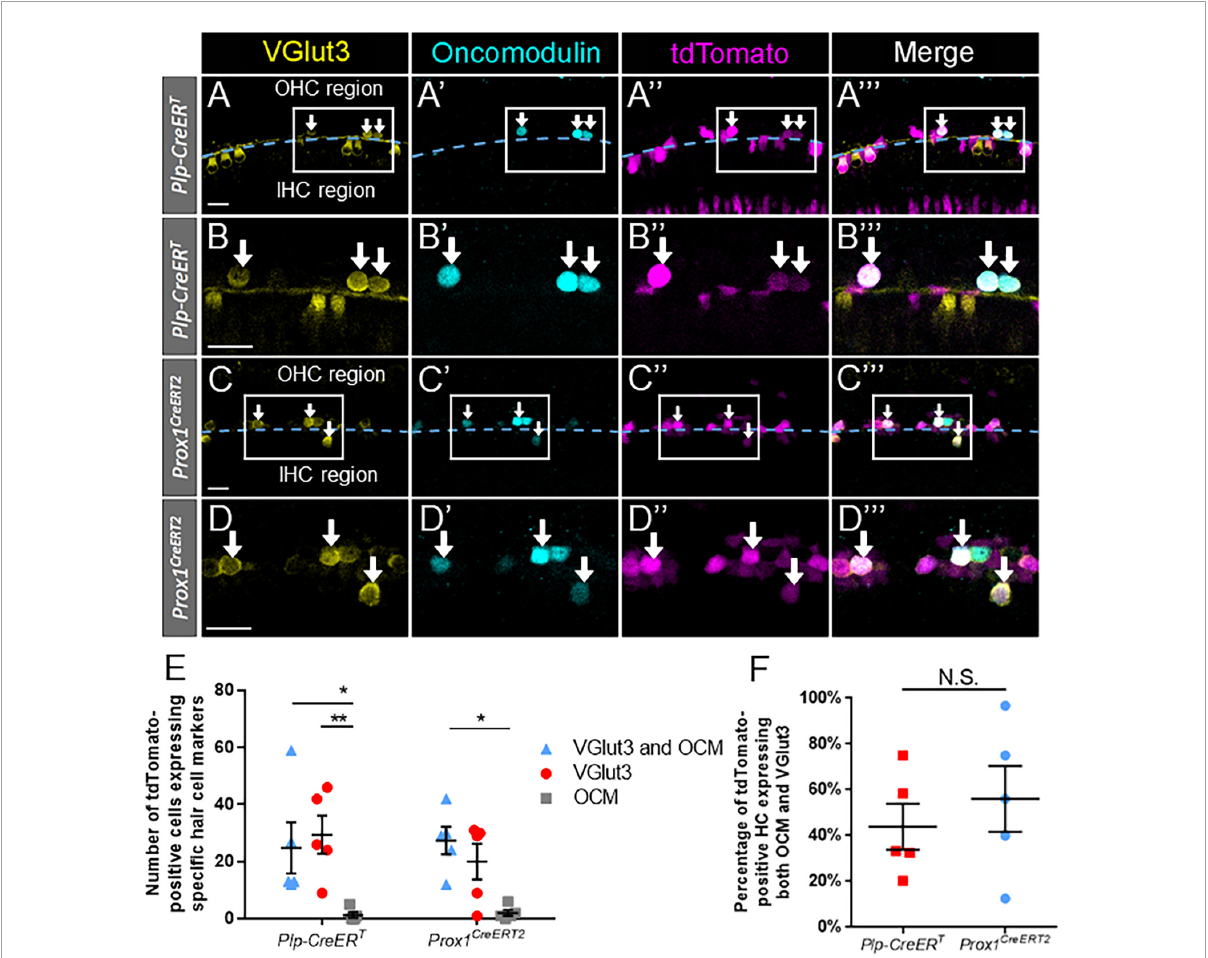
FIGURE6 A large proportion of regenerated hair cells expressed both oncomodulin and VGlut3 across supporting cell subtypes. (A–C”’) Representative confocal slice images from the apical turn of Plp-CreER T :Rosa26 tdTomato :Pou4f3 DTR (A–B”’) and Prox1 CreERT 2 :Rosa26 tdTomato :Pou4f3 DTR (C–D”’) mice at P7–P8 that were injected with tamoxifen at P0 to induce tdTomato expression in the two supporting cell subpopulations and with DT at P1 to induce hair cell damage. Samples were immunostained with anti-VGlut3 antibodies (yellow) as a marker of mature inner hair cells and anti-oncomodulin antibodies (blue) as a marker of immature outer hair cells. tdTomato was detected using endogenous fluorescence (magenta). Arrows indicate VGlut3-positive/oncomodulin-positive/tdTomato-positive cells that are regenerated, fate-mapped hair cells. (A–A”’,C–C”’) Based on their location relative to the tunnel of Corti (dashed blue line), regenerated hair cells were classified as being located in the lateral compartment (upper half of image) or the medial compartment (lower half of image) position. Boxes outline the location where higher magnification images (B–B”’, D–D”’) were taken. All scale bars: 25 µ m. (E) In both population of supporting cells, a significantly greater number of regenerated hair cells (Tomato-positive) expressed both VGlut3 and oncomodulin (blue triangles) compared to those expressing only oncomodulin (gray squares). For regenerated hair cells fate-mapped by Plp-CreER T , the number of cells expressing only VGlut3 (red circles) also significantly exceeded those expressing only oncomodulin. (F) When normalized to the total number of tdTomato- positive hair cells, there was no significant difference in the percentage of VGlut3-positive/oncomodulin-positive regenerated hair cells between the supporting cell populations targeted by the two CreER lines. * p < 0.05; ** p < 0.01, determined using two-way ANOVA with a Sidak’s post-hoc test. Data are presented as mean ± SEM; n = 5. N.S., not significant.